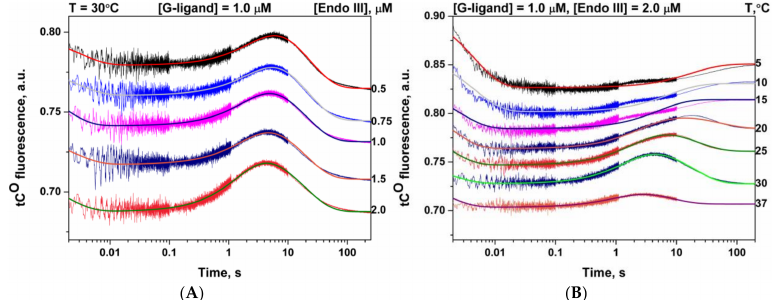
Figure 2. ( A ) Changes in 1,3-diaza-2-oxophenoxazine (tC O ) fluorescence intensity during the interaction of Endo III with G-ligand (1 µ M) at various concentrations of the enzyme at 30 ◦ C. Solid curves represent the curves fitted by means of Scheme 1; ( B ) Changes in tC O fluorescence intensity during the interaction of Endo III (2 µ M) with G-ligand (1 µ M) at different